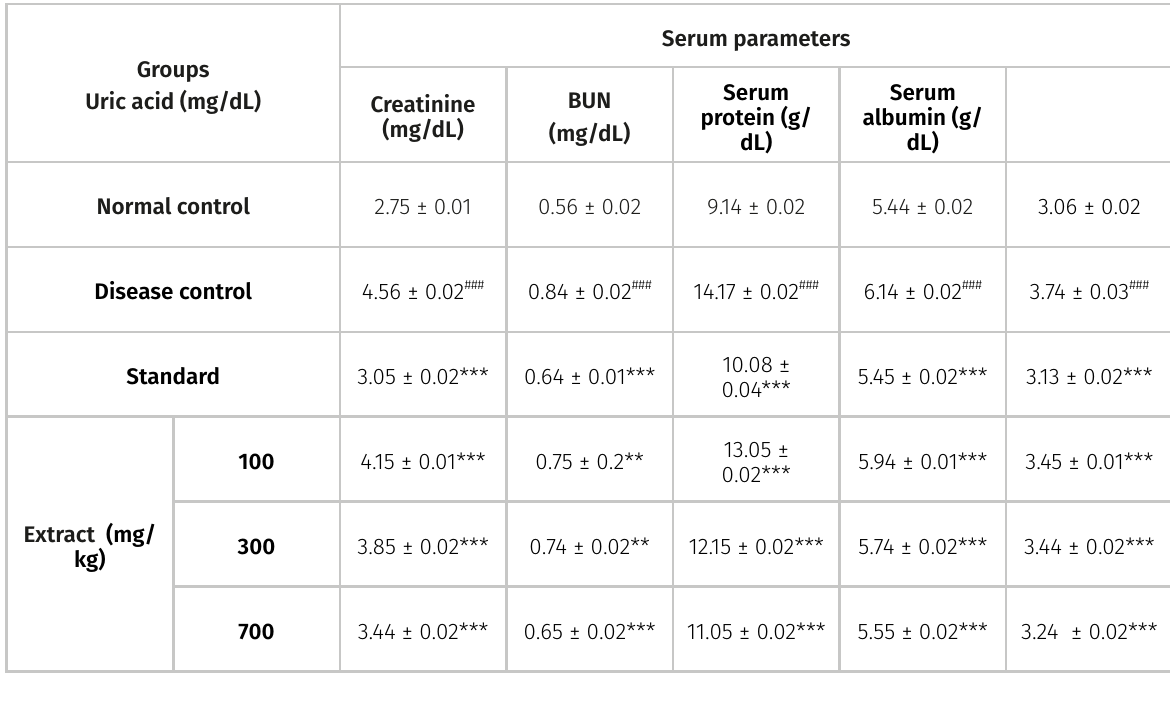
Figure 3. Histopathological analysis of kidney at 10X (a) Normal control; (b) Disease control; (c) Standard; (d-f) Extract treated groups at 100, 300 and 700 mg/kg concentrations